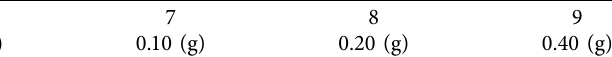
Table 2: Mean value of maximum ground acceleration ( A